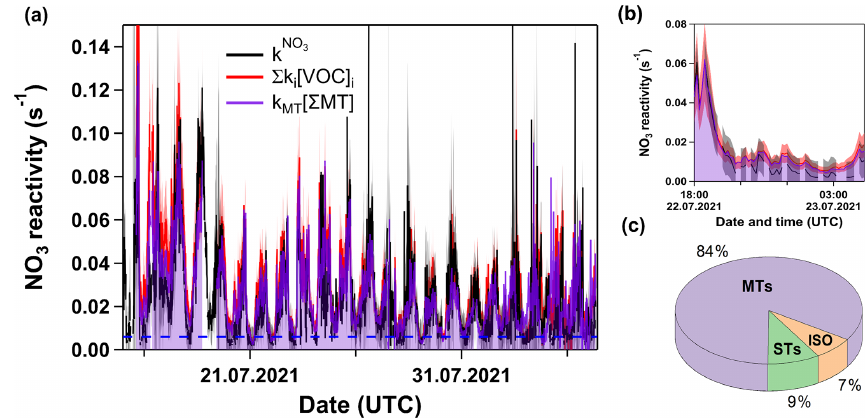
Figure 5. (a) Time series of k NO 3 and (cid:54)k i [VOC] i . Dashed blue line marks the LOD of the k NO 3 measurement. The purple line, together with the same-coloured shade, represents the contribution of monoterpenes. The red and grey shaded areas represent the uncertainty associated with k NO 3 and (cid:54)k i [VOC] i , respectively. (b) Same as panel (a) but with a detailed view of the night between 22 and 23 July presented in Fig. 2b. (c) Pie chart of fractional contributions of isoprene, monoterpenes, and sesquiterpenes to (cid:54)k i [VOC] i over this time period.